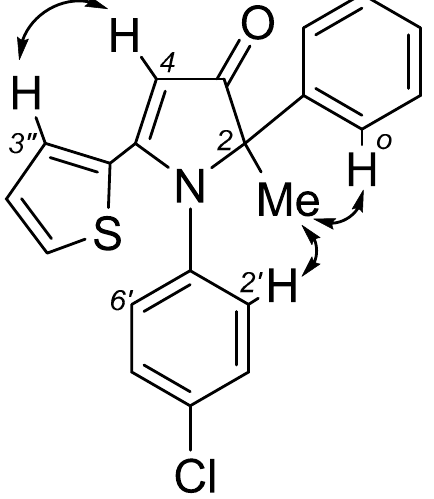
Figure 1. 2D NOESY of 1,2-dihydro-3 H -pyrrol-3-one 2 .